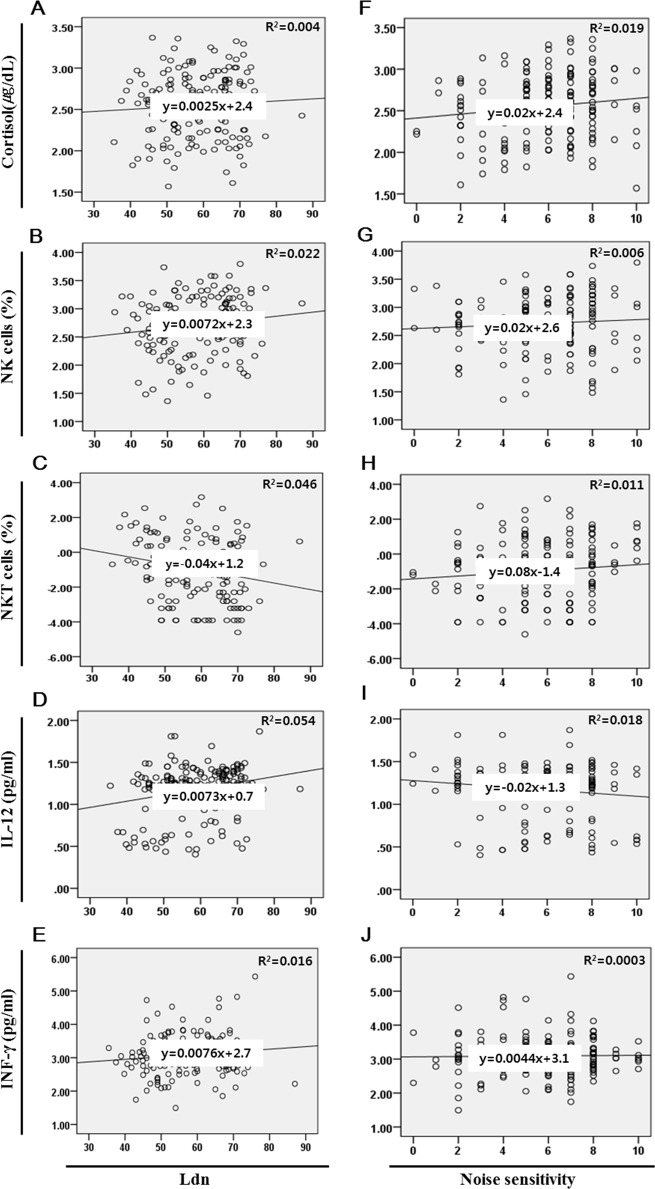
Each real correlation curve for biomarker, Ldn and noise sensitivity.(A-E) It shows each the real correlation curve for Ldn and biomarker such as cortisol (A), NK(B) and NKT cells (C), cytokines (D and E)) and it also shows each the real correlation curve for noise sensitivity and biomarker(F-J).